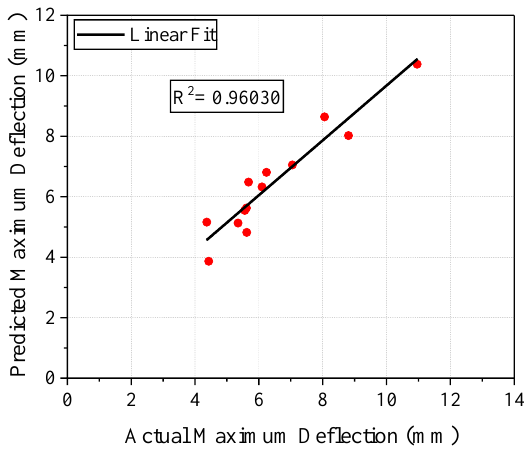
Figure 9. Regression analysis for maximum deflection.